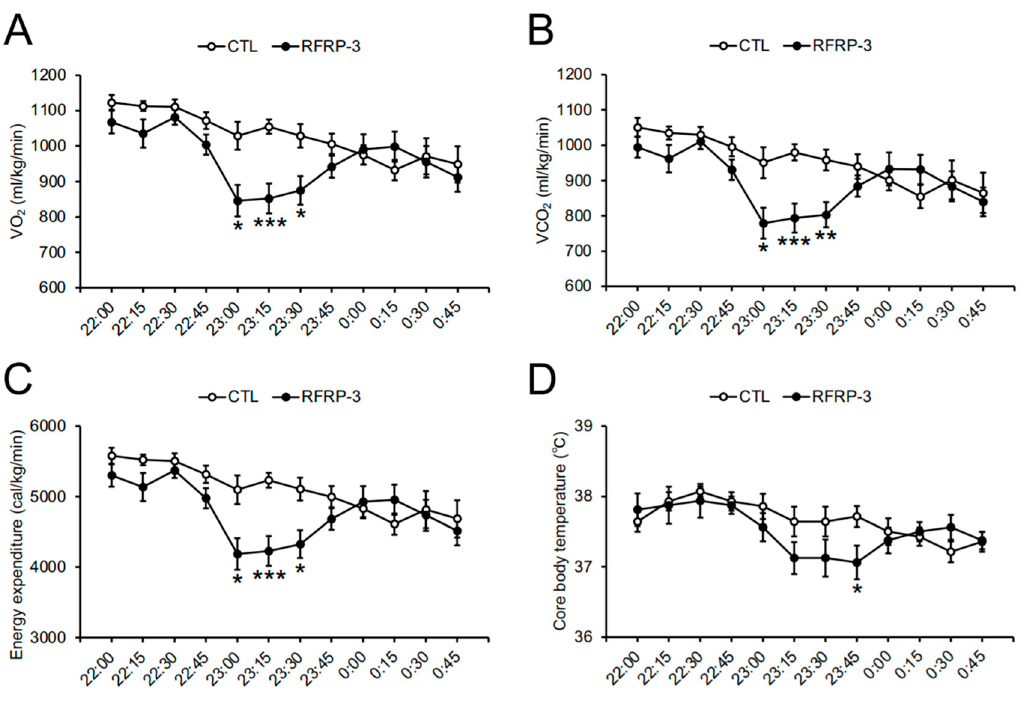
Figure 3. The effects of chronic intracerebroventricular (i.c.v.) infusion of RFamide-related peptide-3 (RFRP-3) on O 2 /CO 2 metabolism hourly. ( A ) O 2 consumption (VO 2 ) measured in the metabolic cage. ( B ) CO 2 production (VCO 2 ) measured in the metabolic cage. ( C ) The respiratory quotient (RQ) measured in the metabolic cage. ( D ) Energy expenditure calculated by VO 2 and VCO 2 . Each value represents the mean ± standard error of the mean. n = 7–8; *** p < 0.005.